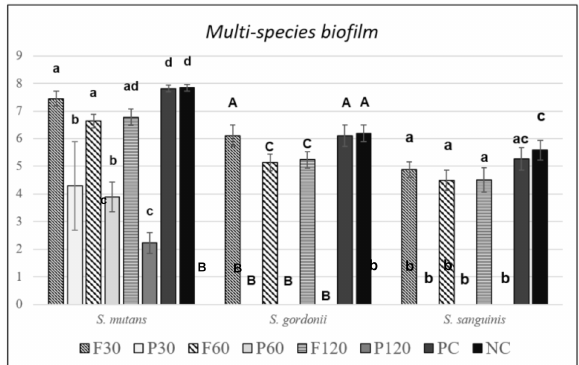
Figure 5. Mean values and standard deviations log 10 CFU/mL of multi-species biofilms formed by S. mutans , S. gordonii , and S. sanguinis , chlorhexidine (positive control), or 0.89% NaCl solution (negative control). Different letters indicate significant statistical difference (n = 9; p ≤ 0.05; ANOVA, Tukey’s Test). F30, F60, and F120 (argon gas—flow control treatment for 30 s, 60 s, and 120 s); P30, P60, and P120 (LTP treatment for 30 s, 60 s, and 120 s); PC (positive control); and NC (negative control).